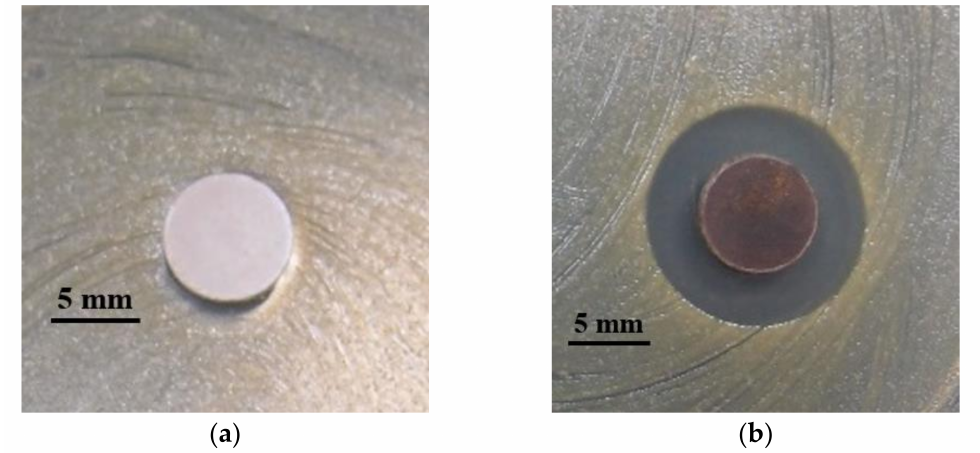
Figure 6. Quality control testing for ( a ) MBG and ( b ) MBG-Ag against MRSA using a disk diffusion